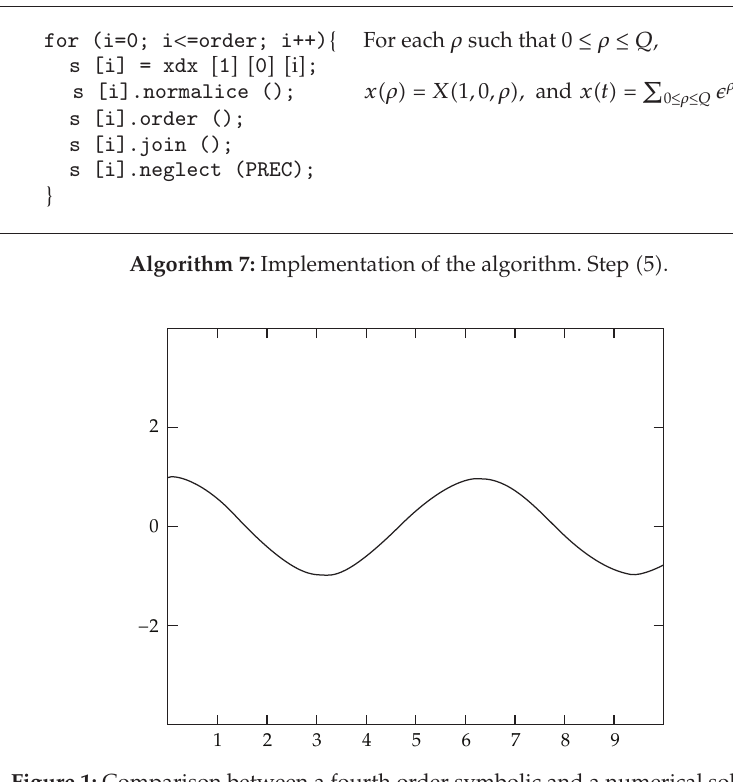
Figure 1: Comparison between a fourth order symbolic and a numerical